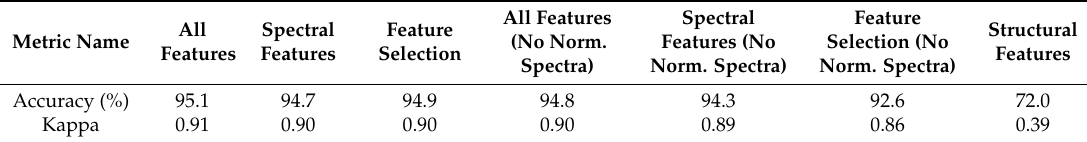
Table 13. Effect of different feature sets to classification using